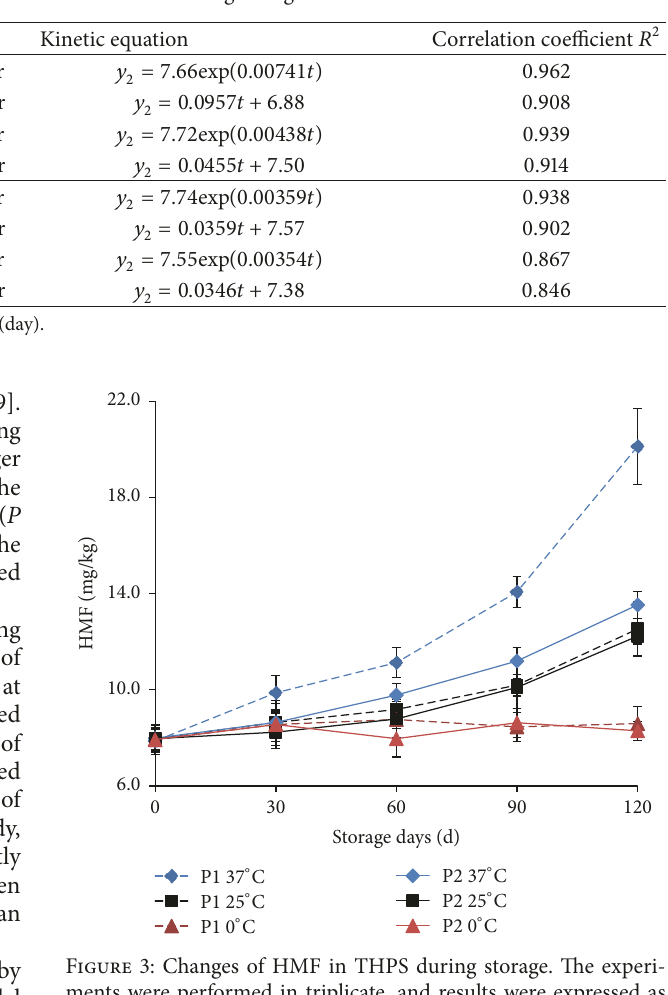
Table 2: Kinetic equation of HMF in THPS during storage.